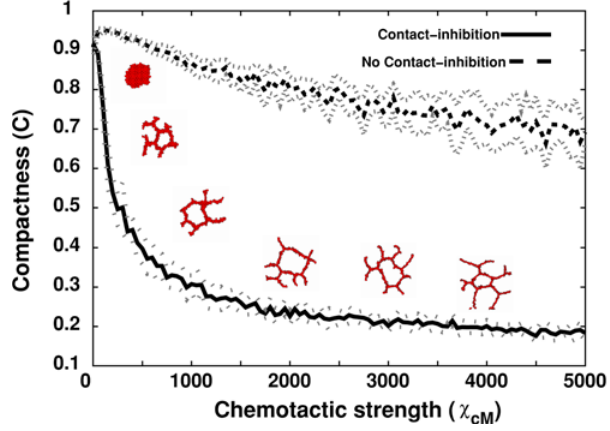
Figure 8. Compactness ( C = A cluster / A hull ) of 128-cell clusters on 200 6 200-pixel lattices ( , 400 m m 6 400 m m ) after 5000 MCS ( , 40 h) for standard chemotaxis as a function of absolute chemotactic strength, x ( c , M ). Insets: Representative configurations after 5000 MCS ( , 40 h).